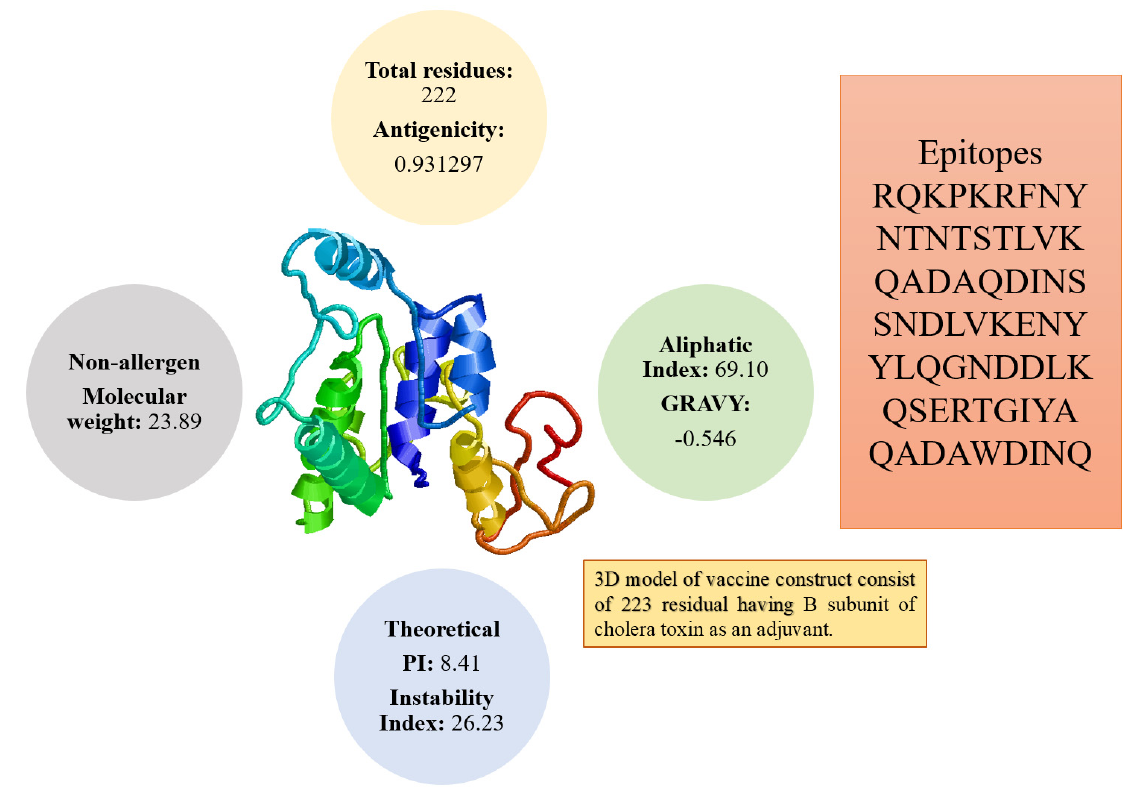
Figure 4. Different physicochemical properties, 3D model, and epitopes sequence of the designed vaccine construct.